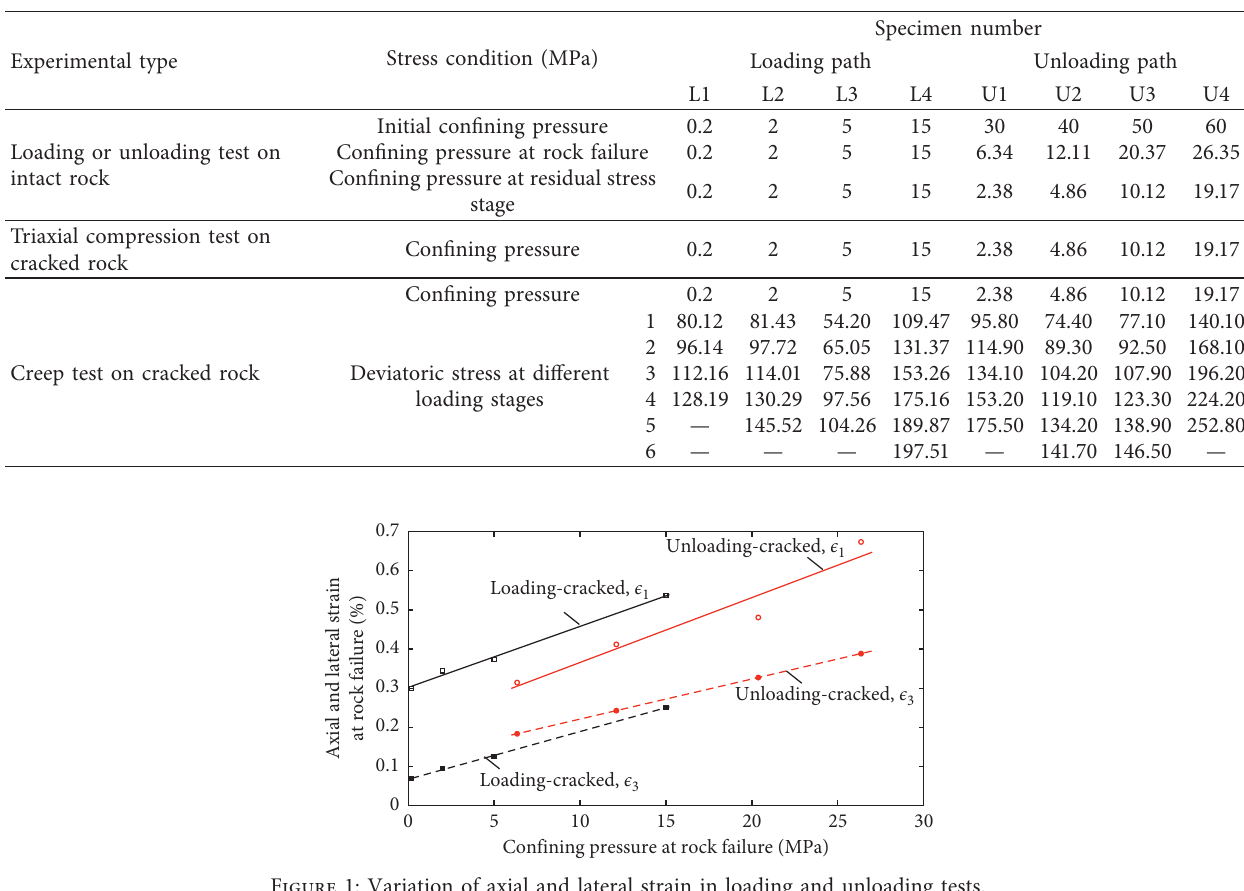
Table 1: Stress conditions and loading path of each test.